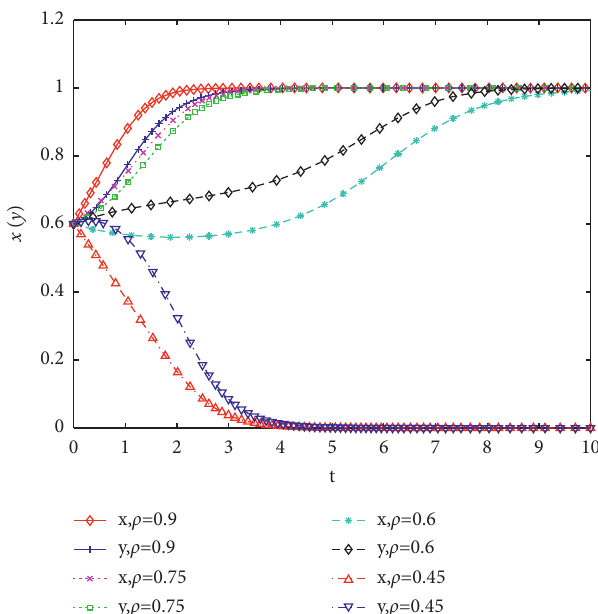
Figure 11: The stability analysis of Model II under different ρ .